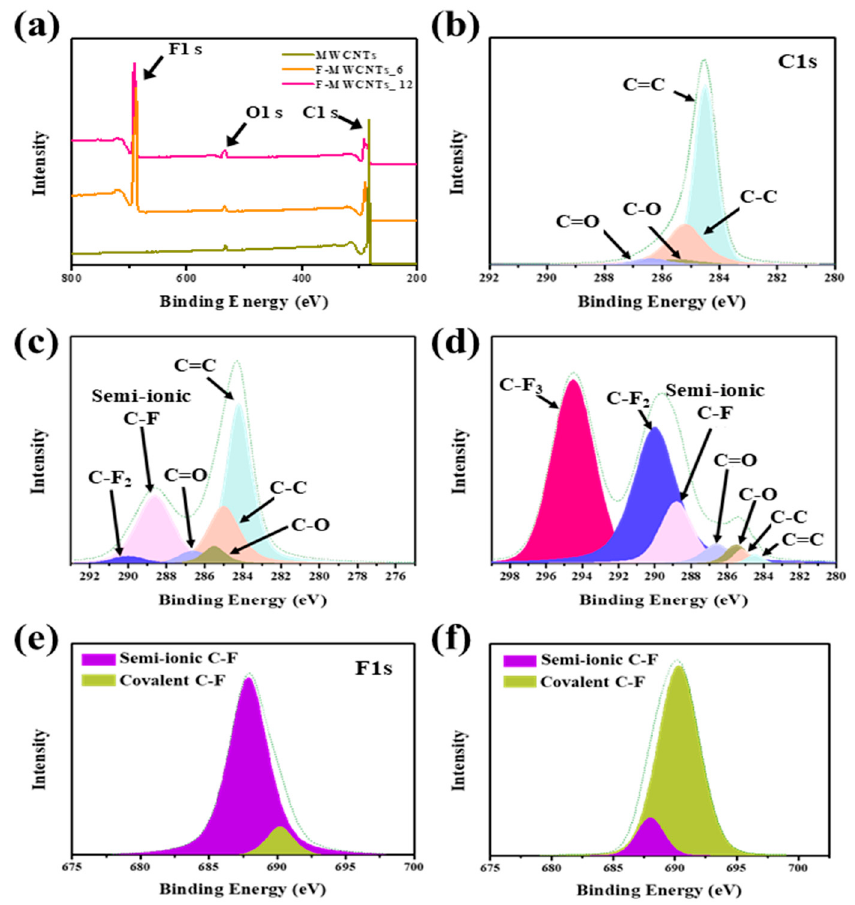
Figure 1. ( a ) X-ray photoemission spectroscopy (XPS) profiles of MWCNT, F-MWCNT 6 and F- MWCNTs_12. ( b – d ) C 1s spectra of the MWCNTs, F-MWCNTs_6 and F-MWCNTs_12. ( e , f ) F 1s spectra of the MWCNTs, F-MWCNTs_6 and F-MWCNTs_12. The XRD patterns of the MWCNT and fluorinated samples are shown in Figure S1.